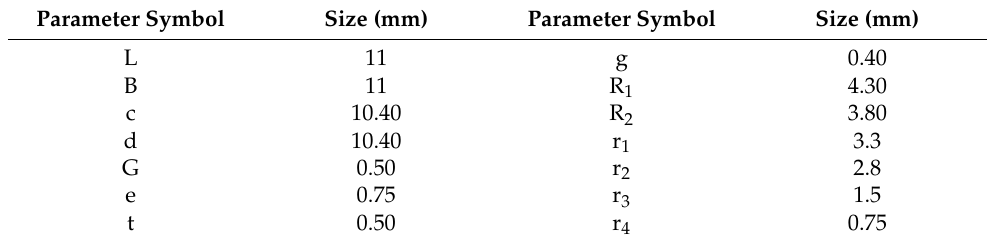
Table 1. Geometric values of the unit cell configuration .